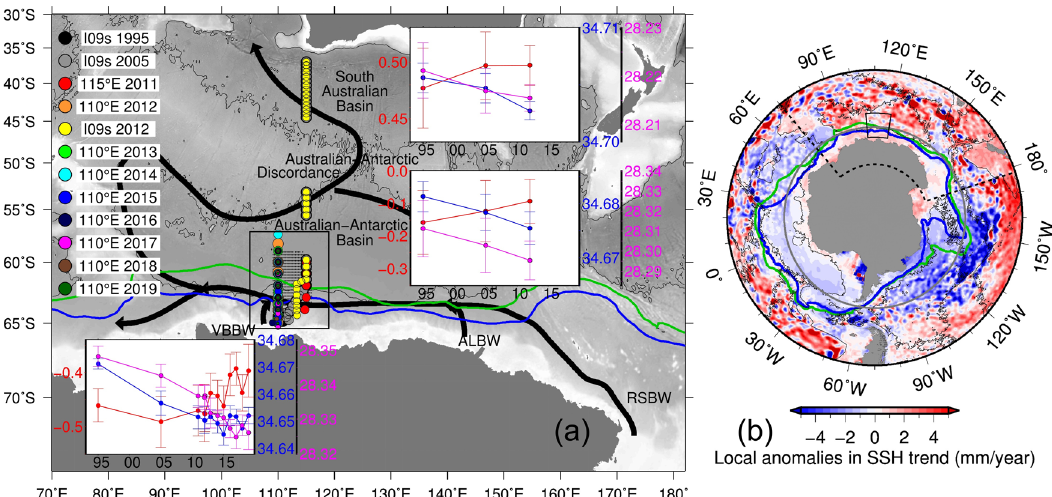
Fig. 1 Location of the study area with a schematised Antarctic Bottom Water (AABW) pathway and satellite-observed sea-level rise (SLR) in the Southern Ocean. a Observation points are coloured according to year. The solid black frame indicates the core region in the Australian-Antarctic Basin (core AAB). The hatched area indicates satellite altimeter data points used for comparison with steric SLR. Black arrows indicate AABW pathways; 33 major sources of Ross Sea Bottom Water 15 , Adélie Land Bottom Water 19 and Vincennes Bay Bottom Water 22 are shown. The solid black line indicates the 4000 m isobath. Upper, middle and lower insets are the time series of the bottom properties in the South Australian Basin, northern AAB and core AAB, respectively. In each inset, potential temperature (red), practical salinity (blue), and neutral density (pink) averaged over 100 m from bottom are shown with error bar indicating standard deviation. b Local anomalies in sea-surface height (SSH) trends compared to the overall Southern Ocean. Linear SSH trends were estimated at each data point, and the mean rate of SLR in the Southern Ocean was subtracted. Only satellite altimeter data from ice-free months (January – April) between 1993 and 2018 were used 5 . The solid black and grey lines in b indicates the 4000 m isobath and 62°S latitude, respectively. The areas encompassed by broken and solid lines correspond to the entire domain of a and the core AAB region, respectively. The green and blue lines in a and b , respectively, indicate climatological position of the Southern Antarctic Circumpolar Current Front and southern boundary 34 estimated using observed data prior to the year 2013 32